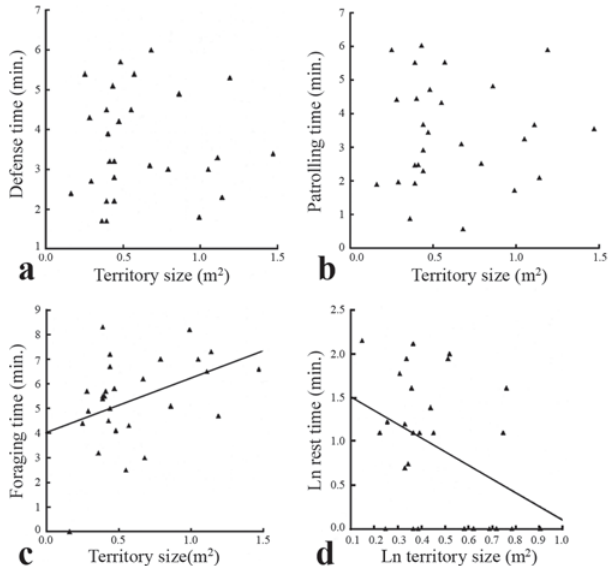
Fig. 2. Relationship between the number of attacks on intruders (a), the time foraging (b) and the time resting (c) with the size of the territory defended by Parodon nasus in a stream in Serra das Araras, State of Mato Grosso, Brazil (October